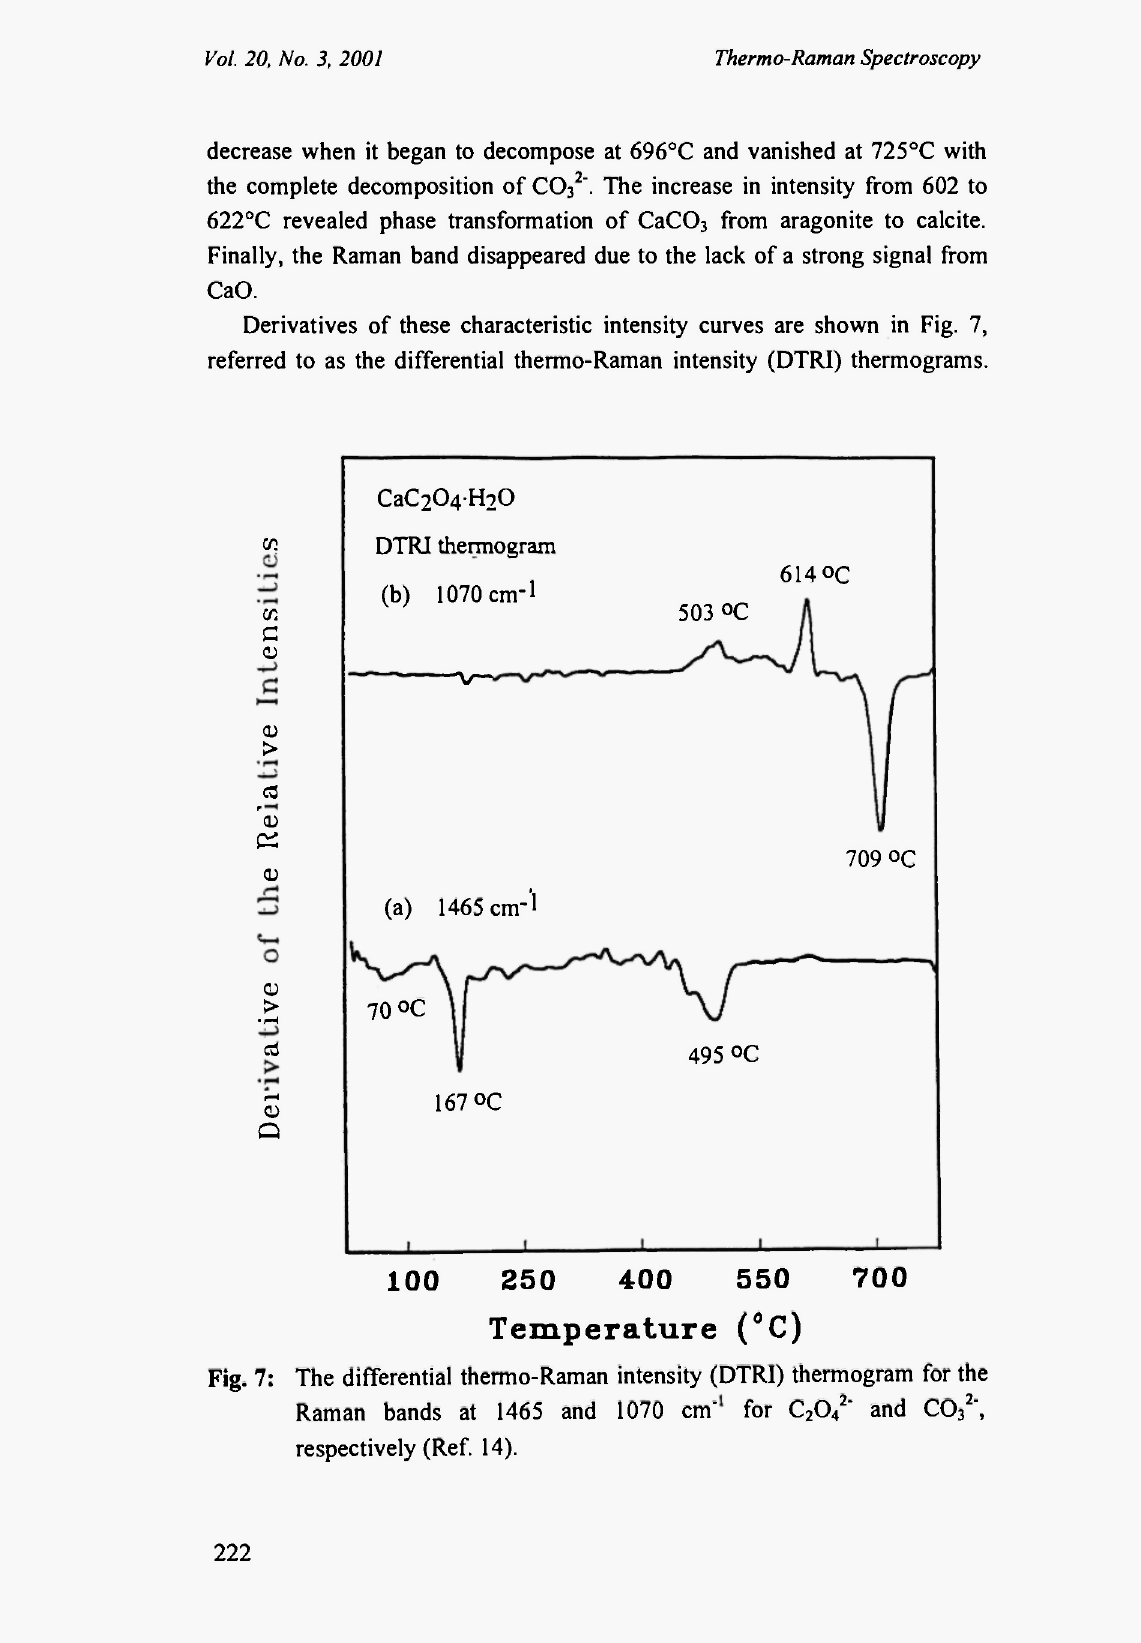
Fig. 7: The differential thermo-Raman intensity (DTRI) thermogram for the Raman bands at 1465 and 1070 cm" respectively (Ref. 14).